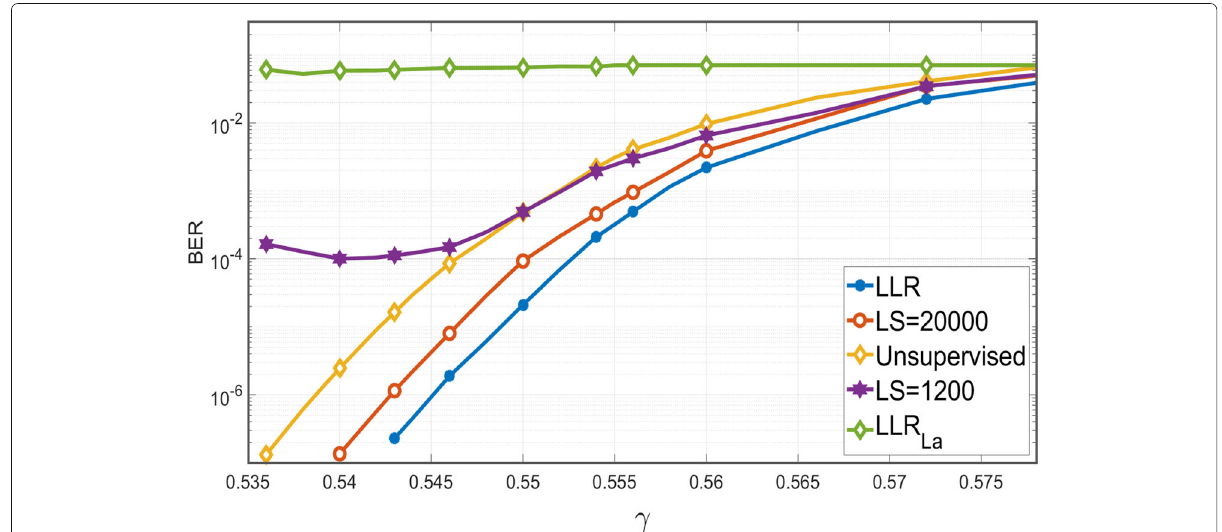
Fig. 7 BER comparison in low impulsive S α S noise. Evolution comparison of the BER as a function of the dispersion γ of a S α S noise in low impulsive environment with α = 1.8, between the supervised with different learning sequence sizes, unsupervised, Gaussian designed LLR approximations,